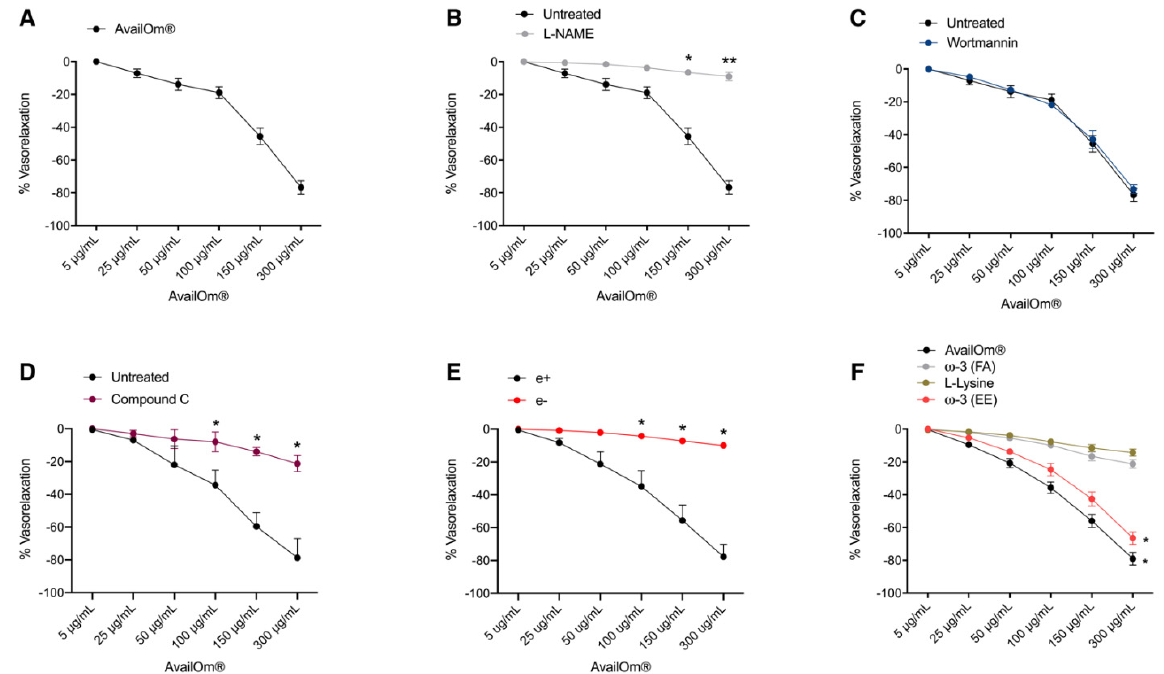
Figure 1. Evaluation of the vasorelaxant effects of AvailOm ® and its fractions in mice mesenteric arteries. ( A – D ) Vascular reactivity function of phenylephrine-precontracted mice vessels to increasing doses of AvailOm ® (5–300 µ g/mL) (N = 5). ( B ) Vascular response of phenylephrine-precontracted mice mesenteric arteries to increasing doses of AvailOm ® in in the presence of L-NAME, ( C ) wortmannin, ( D ) Compound C or ( E ) in vessels with endothelium (e+) or without endothelium (e − ). ( F ) Comparison of the vasorelaxant effect of AvailOm ® , ω -3 FA, ω -3 EE or L-Lysine. Statistical analyses were performed using two-way ANOVA followed by Bonferroni post hoc test. * p < 0.05; ** p < 0.01.